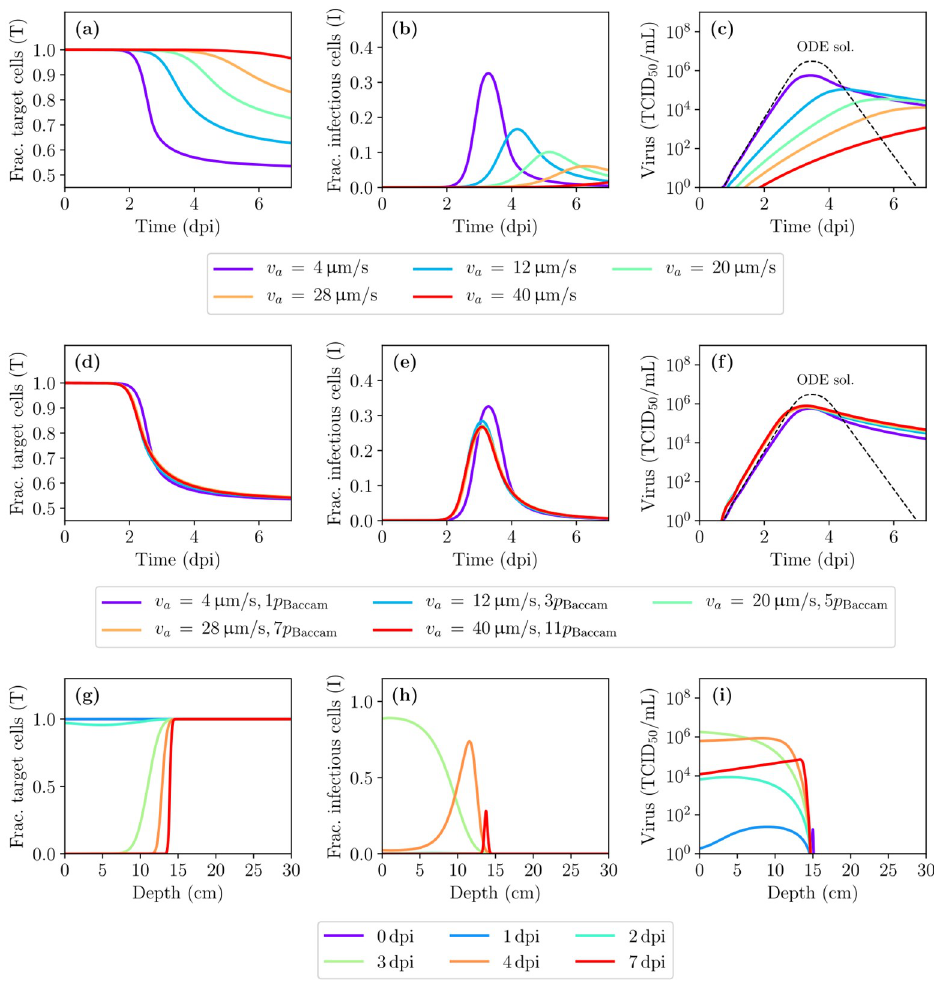
Fig 5. The effect of advection speed on the MM predictions of IAV infection kinetics. (a–f) Time course (averaged over space) of the infection for the fraction of cells in the (a,d) target/uninfected or (b,e) infectious states, and (c,f) the infectious virus concentration, as the advections speed ( v ) is varied either (a,b,c) on its own; or (d,e,f) along with the a virus production rate so as to keep virus peak titer and timing constant. (g–i) Spatial distribution of the infection at various days post-infection for an advection speed v = 4 μ m/s and virus production rate p Baccam . a